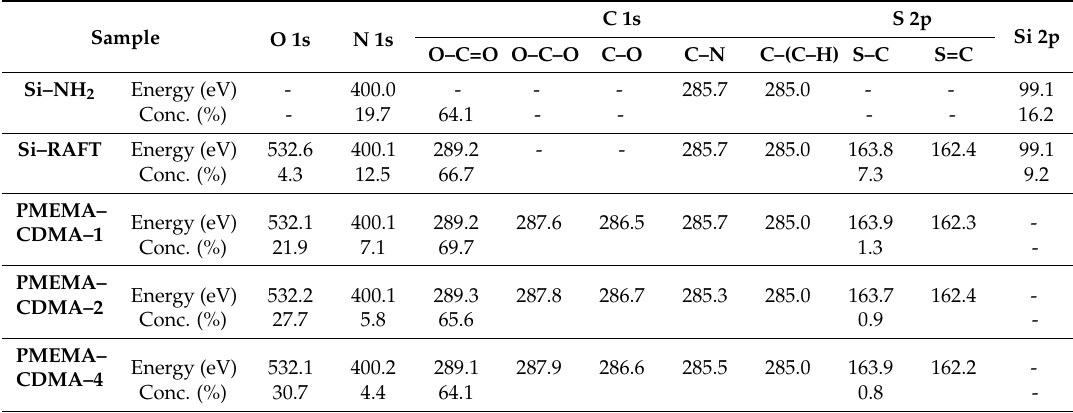
Table 1. Atomic concentration (Conc.) and binding energies obtained from high-resolution X-ray photoelectron spectroscopy (XPS) for PMEMA brush-gels 1 .